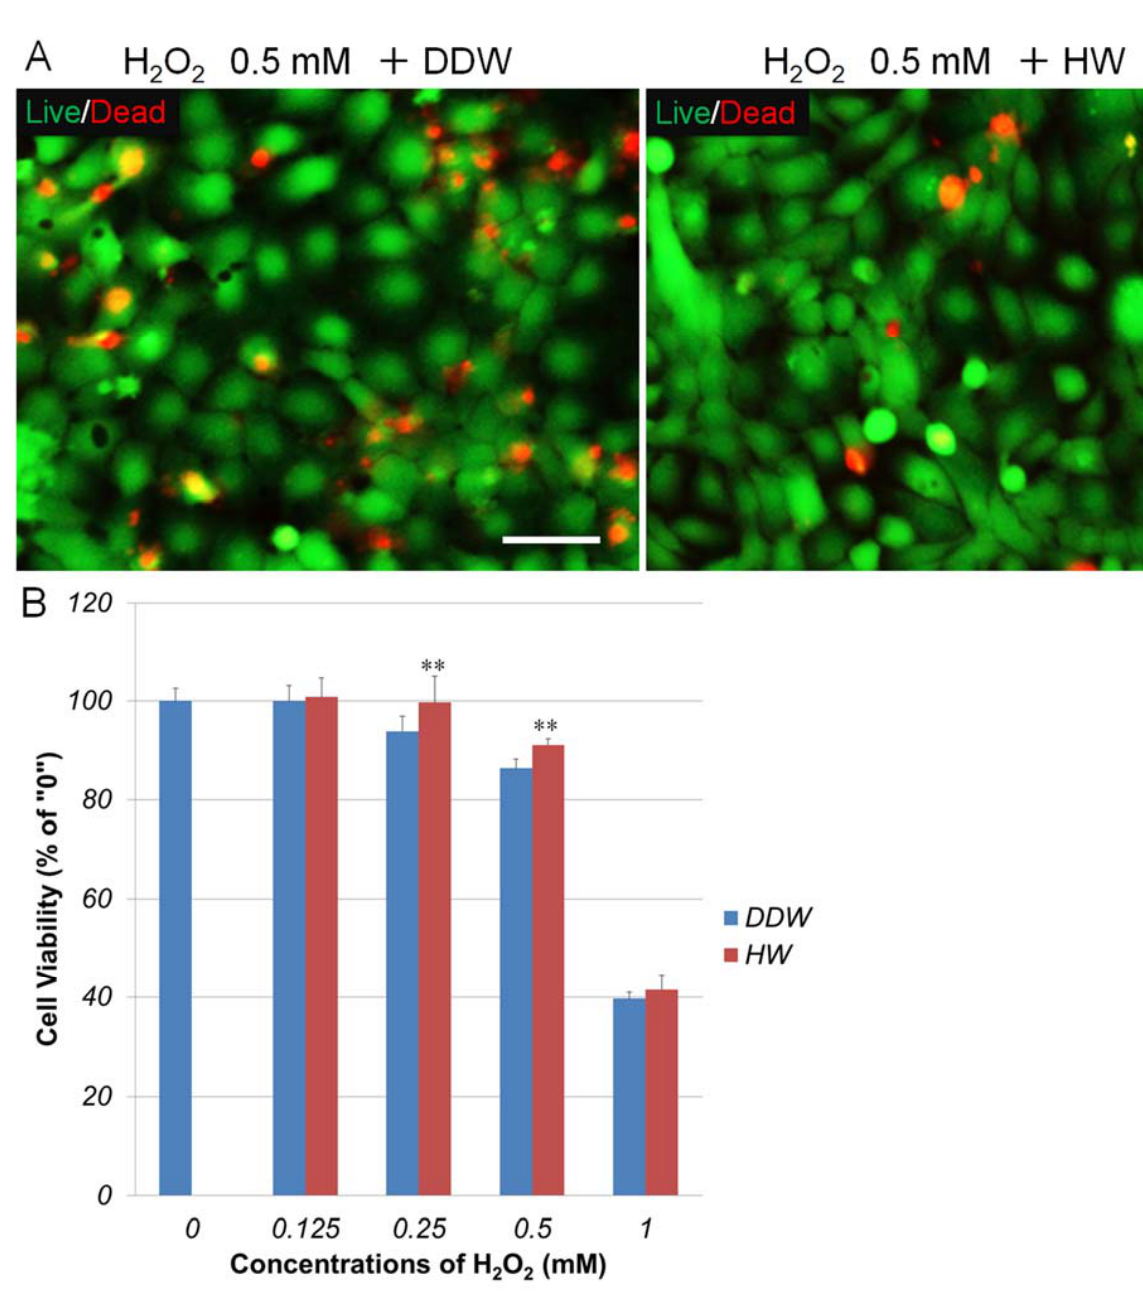
Figure 2. Repressive effects of HW on hydrogen peroxide-induced cell death in human keratinocytes HaCaT. HaCaT cells were pretreated with double-distilled water (DDW)- or HW-prepared medium for 2 h. Cells were then exposed to H 2 O 2 at different concentrations. After 48 h, cell viability was measured by PrestoBlue Assay. ( A ) HaCaT cells were stained by Live/Dead staining. Green, live cells; red, dead cells. Scale bar = 50 µm ( B ) results of PrestoBlue Assay. ** p < 0.01 vs. 0 (without H 2 O 2 treatment). Each bar represents the mean ± SD of three independent experiments.